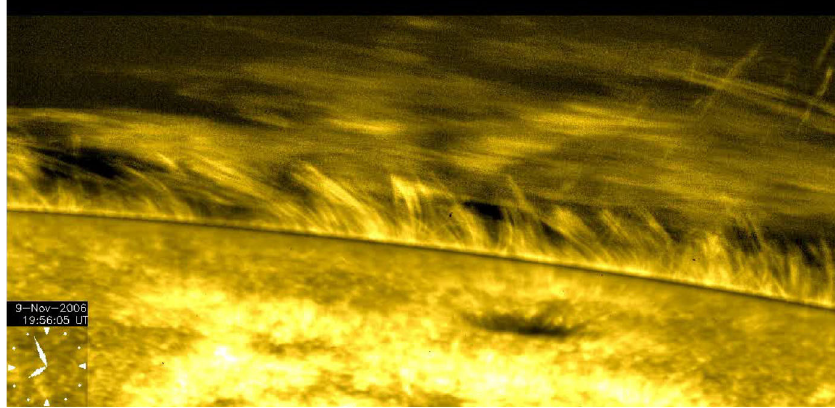
Fig. 29 Still from a movie showing Ca ii H line images taken with Hinode/SOT that shows ubiquitous continuous horizontal motions along the prominence threads at the top right of the image. These threads also oscillate up and down as they flow (from Okamoto et al. 2007). (To watch the movie, please go to the online version of this review article at doi:10.1007/s41116-018-0012-6) (2007) using Hinode/SOT. A Ca ii H line movie shows continuous horizontal